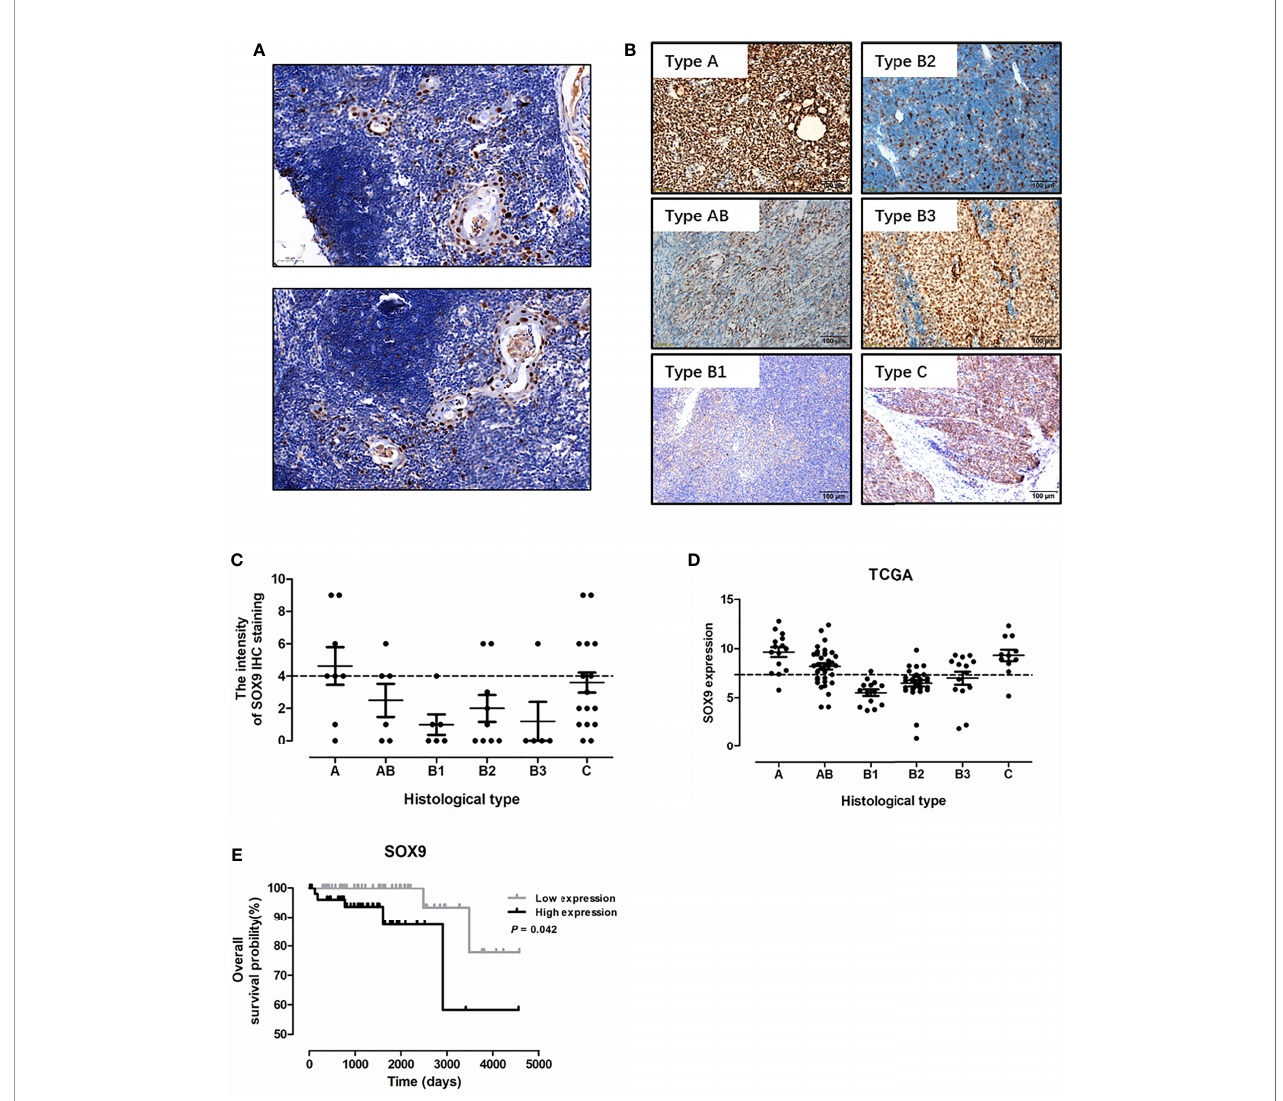
FIGURE 1 | SOX9 expression in thymic epithelial tumors and its prognostic signi fi cance. (A) Representative immunostaining images for SOX9 expression in the epithelial cells of Hassall ’ s corpuscles in the non-tumor area of thymic epithelial tumors. (B) Representative immunostaining images for SOX9 in different histological types of thymomas and thymic carcinomas. (C) The distribution of SOX9 expression intensity quanti fi ed by IHC staining in thymomas and thymic carcinomas in our cohort. (D) The distribution of SOX9 RNA expression in thymomas and thymic carcinomas in the TCGA dataset. (E) Kaplan – Meier survival curves showing that thymoma patients from TCGA dataset with high SOX9 RNA expression had shorter overall survival time ( P < 0.05), as determined by the log-rank test. Thymoma patients (n = 108) were categorized into high and low SOX9 expression groups with the median value of SOX9 mRNA expression level as cutoff.